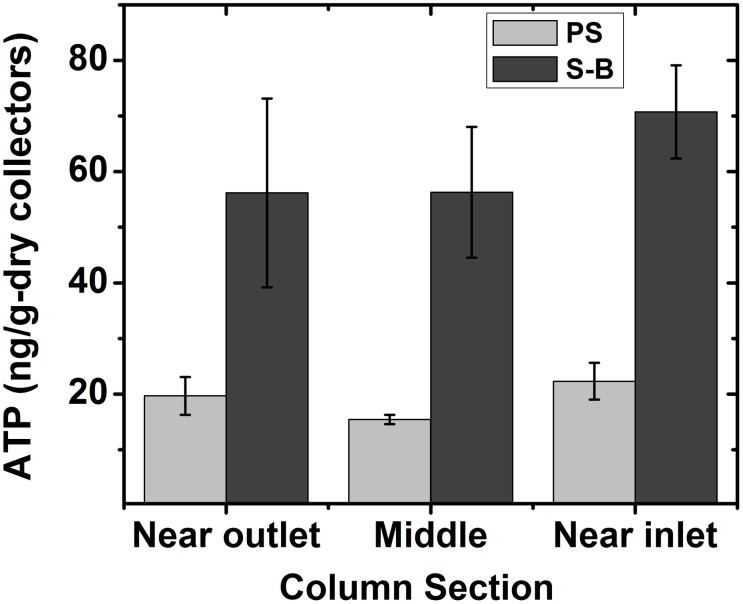
Variation of biomass supported by sand (PS) and biochar-augmented sand (S-B) columns after 120 h.Adenosine triphosphate (ATP) was used as a measure of active biomass present within the porous media. Error bars represents one standard deviation between replicate measurements (n = 3).